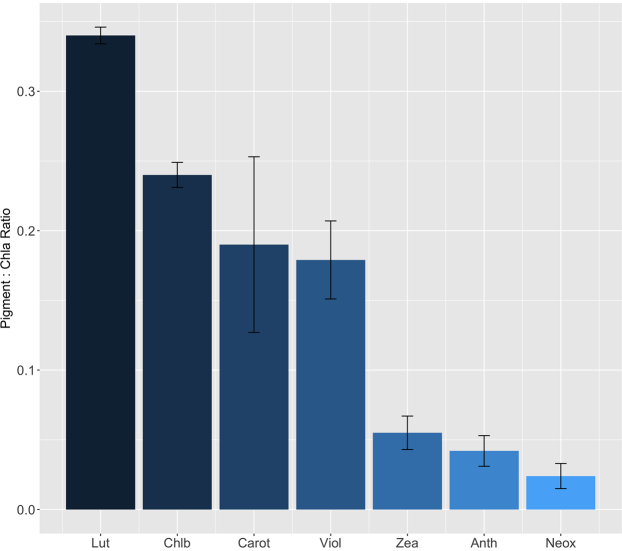
Ice algal chlorophyll and carotenoid pigment ratios relative to chlorophyll a (33.02 ± 8.00 fg Chla per pg C−1) assessed from surface ice samples collected at S2 during transect 1 (mean ± SE, n = 5). Lut = lutein, Chlb = chlorophyll b, Carot = β-carotene, Viol = violaxanthin, Zea = zeaxanthin, Anth = antheraxanthin, Neox = neoxanthin.